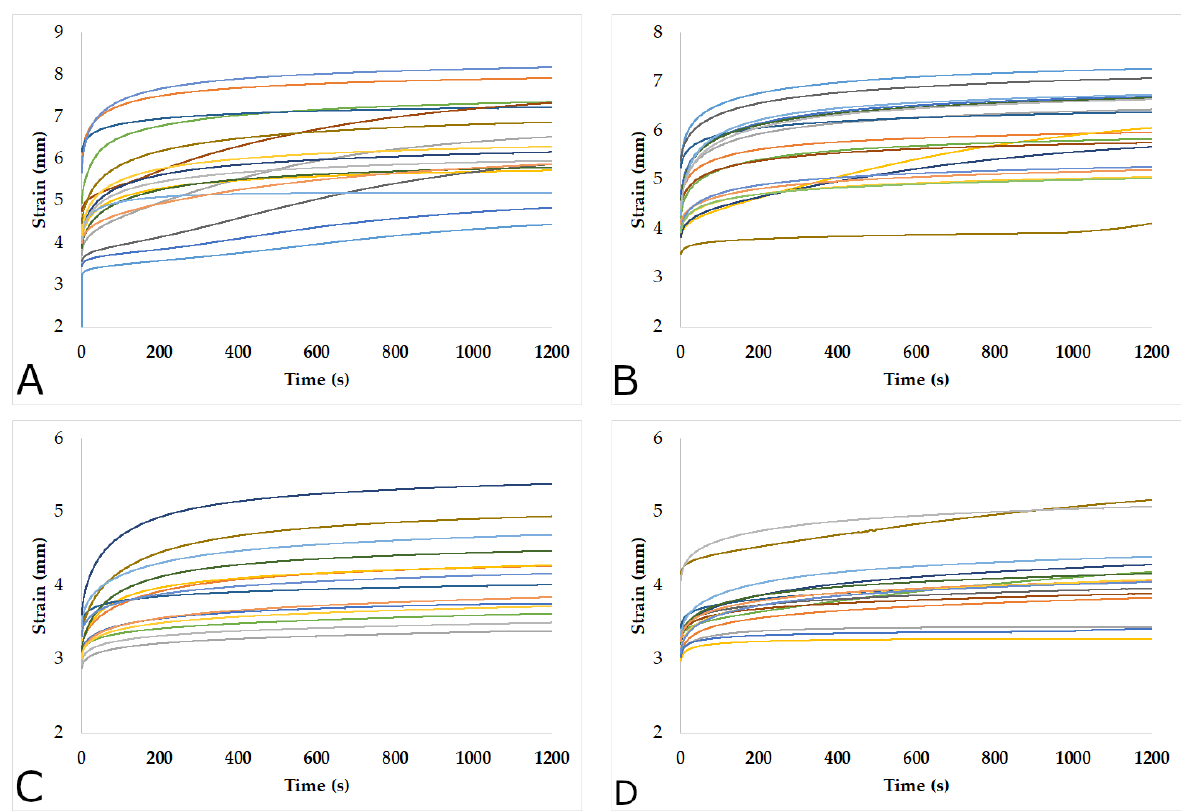
Figure 5. Evolution of the pieces with a density of 0.43 g cm −3 subjected to tensile creep: Load 1530 N: ( A ) tangential; ( B ) radial. Load 1170 N: ( C ) tangential; ( D ) radial.